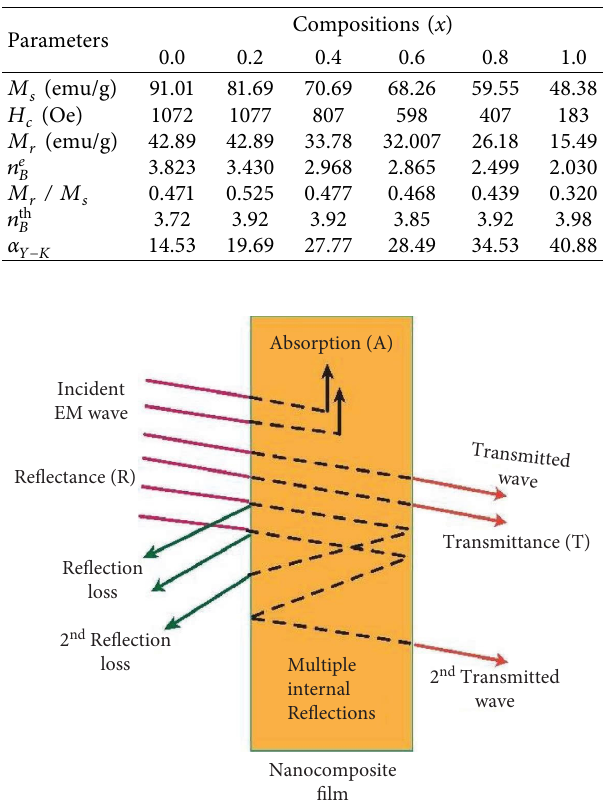
Table 6: Magnetic properties of diferent compositions of